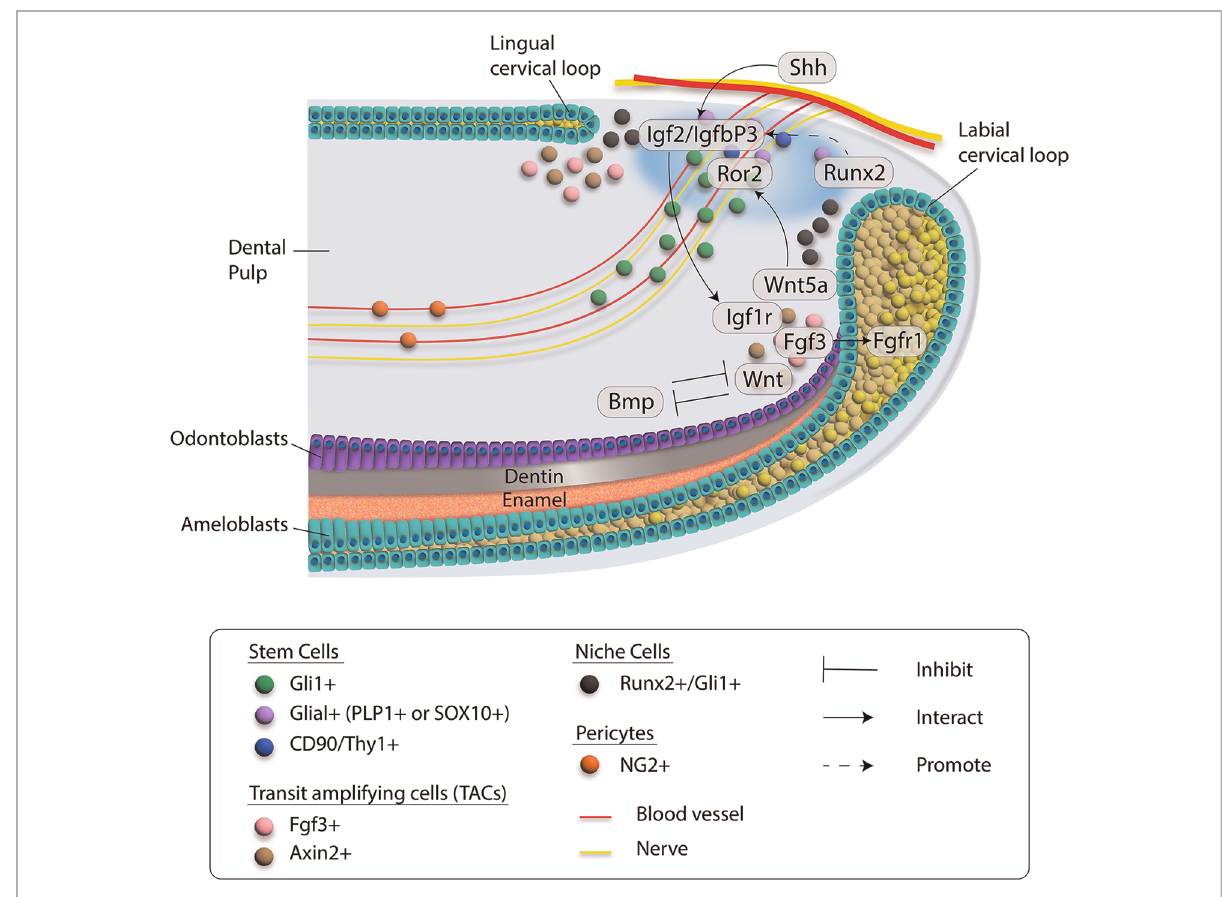
FIGURE 2 Schematic diagram of cell-cell communication in the proximal region of the mouse incisor. Different cell types are indicated by colored dots. Blood vessel and nerve are drawn in red and yellow, respectively. Critical molecules involved in signaling networks are listed and interactions among them are indicated by different types of lines. Details are included in the